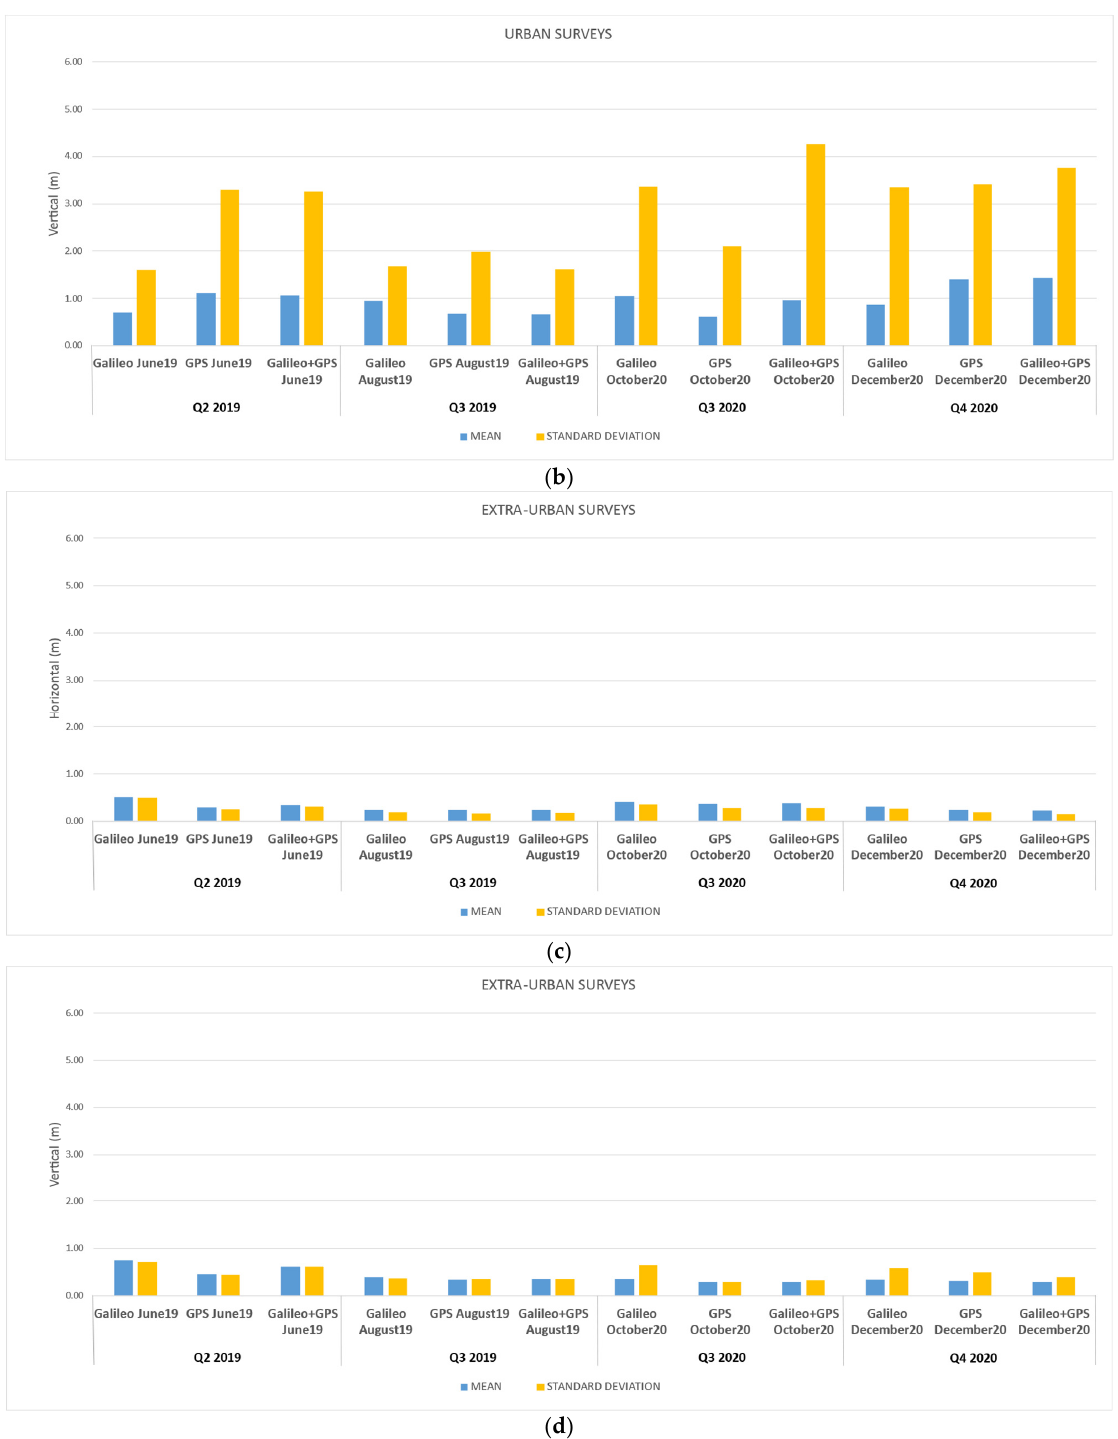
Figure 13. Horizontal and vertical mean values and standard deviations (in meters) for the different campaigns in terrestrial environments (urban and extra-urban) using CSRS-PPP as reference ( a ) and ( b ) for urban and ( c , d ) for extra-urban surveys.